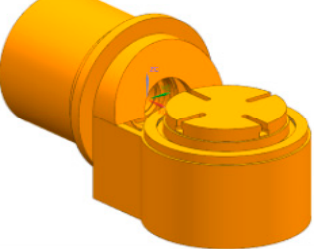
Figure 3. Three-dimensional model of direct-drive turntable.